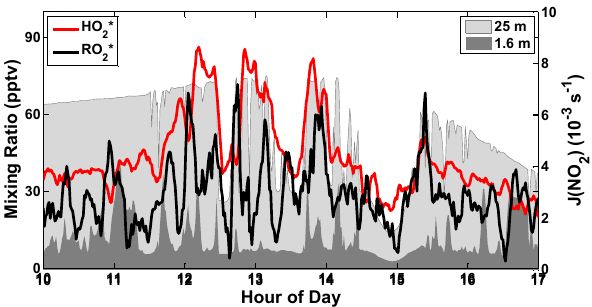
Fig. 8. Example of fast midday variations of solar radiation and per- oxy radicals for day 234 (22 August). HO ∗ are plotted on the left axis, while NO 2 photolysis frequencies are plotted on the right axis for both above-canopy (light gray) and below-canopy (dark gray) measurements. All data are 1min aver-